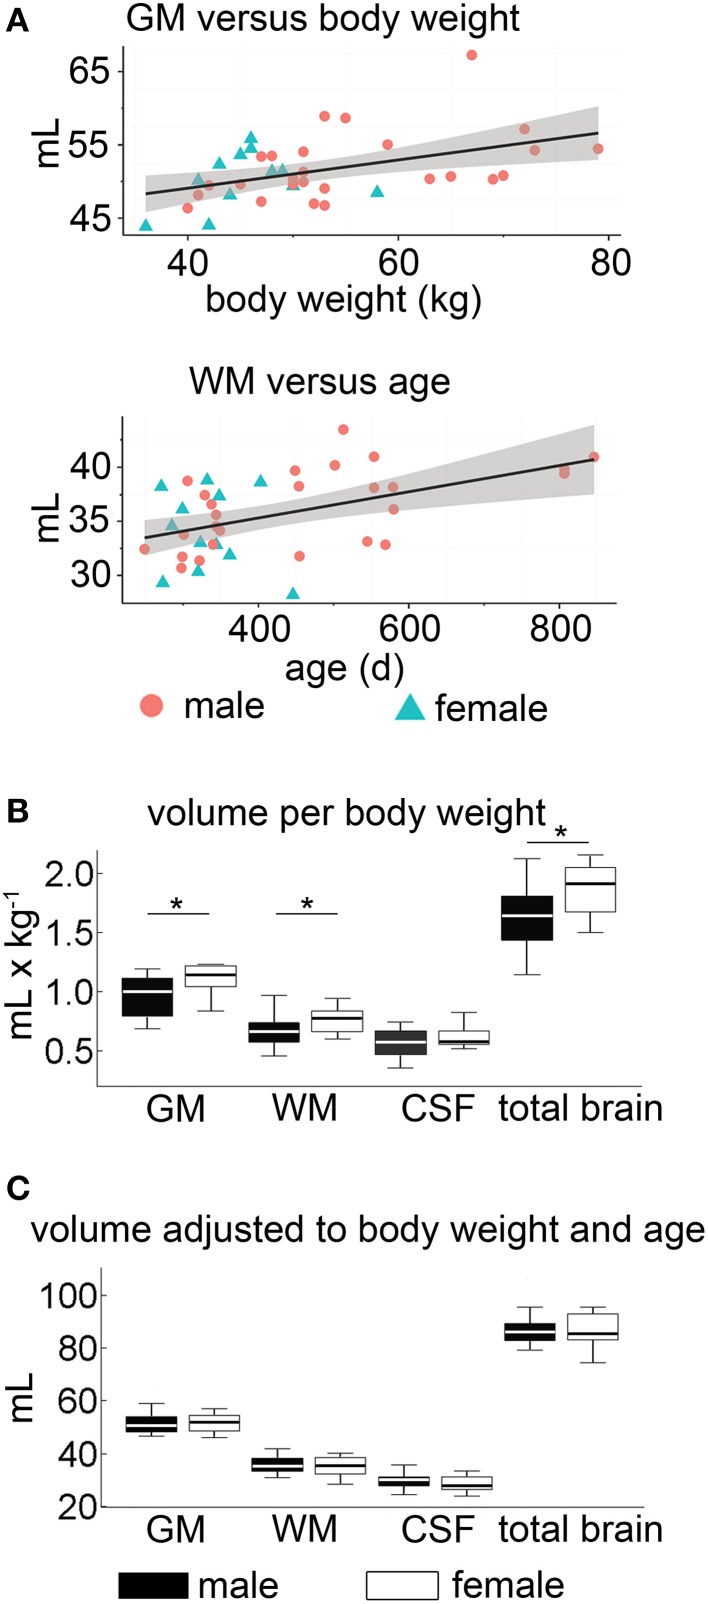
Volumetric analyses within the proof-of-principle study. (A) The correlation of body weight on GM and age on white matter WM volumes, respectively, showed a slight positive correlation. (B) Sex differences: significant tissue volume differences of GM and WM were observable between male (black) and female (white) sheep when normalized to BW (*p < 0.05). (C) When simultaneously accounting for the effect of body weight and age in a linear model, no statistical differences of the absolute adjusted brain tissue volume between the sexes were detectable (p > 0.05). The box plots show 95% confidence interval, 25/75% quartile and median. GM, gray matter; WM, white matter; CSF, cerebrospinal fluid; BW, body weight.